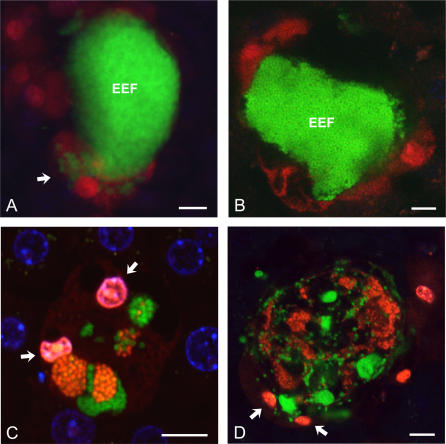
Hepatocyte and Merozoite Viability during Merosome FormationAt 52–70 h after infection with PyGFP, mice were intravenously injected with a mixture of the membrane-permeable DNA stain Hoechst 33342 and the dead cell dye PI prior to intravital microscopic examination. (A) Confocal scan showing an intact EEF that has not incorporated PI (red) and is therefore considered viable. Note that merozoites have been discharged into surrounding cells (arrow) some of which have taken up the red dead cell stain.(B) Due to merosome formation, this EEF has decreased in size and detached from the surrounding tissue. The neighboring cells appear to be compressed and are stained with PI (red).(C) A few merozoites are left behind in an EEF that has disintegrated after repeated merosome budding. The two nuclei of the host cell (arrows) have incorporated predominantly PI (red) and some Hoechst stain (blue) and appear pink. In addition, some of the merozoites have lost their green fluorescence and appear red due to PI staining, while others have retained GFP and excluded PI and are therefore viable. The nuclei of the neighboring hepatocytes are visualized by Hoechst staining (blue).(D) EEF at a late stage of disintegration. Some remaining merozoites are viable (green), while other merozoites are dead (red). The nuclei of some surrounding cells have also incorporated PI (arrows). Bars = 10 μm.